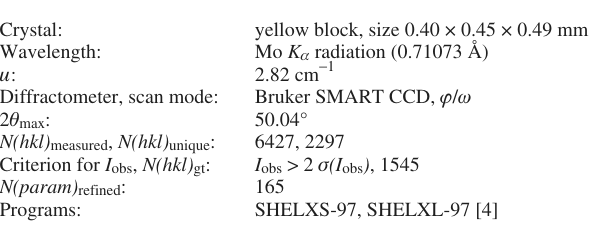
Table 1. Data collection and handling.